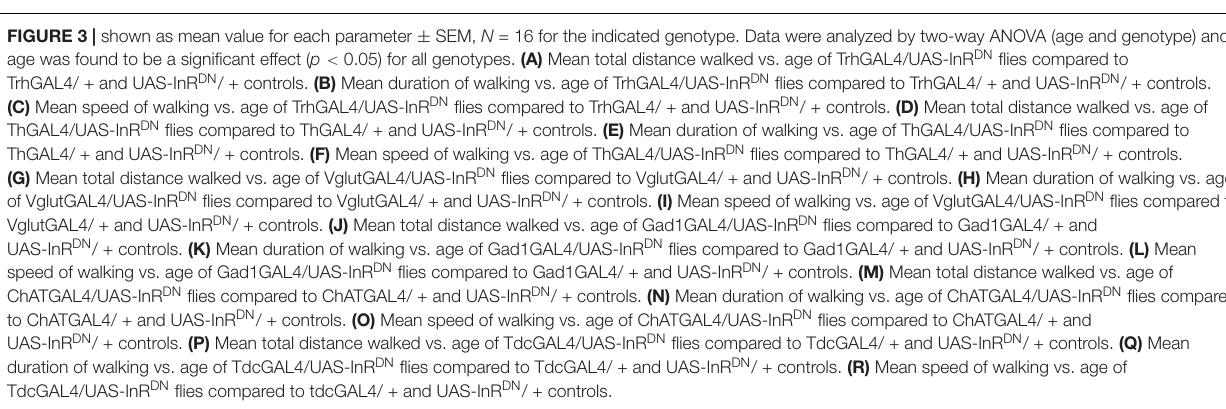
FIGURE 3 | shown as mean value for each parameter ± SEM, N = 16 for the indicated genotype. Data were analyzed by two-way ANOVA (age and genotype) and age was found to be a significant effect ( p < 0.05) for all genotypes. (A) Mean total distance walked vs. age of TrhGAL4/UAS-InR DN flies compared to TrhGAL4/ + and UAS-InR DN / + controls. (B) Mean duration of walking vs. age of TrhGAL4/UAS-InR DN flies compared to TrhGAL4/ + and UAS-InR DN / + controls. (C) Mean speed of walking vs. age of TrhGAL4/UAS-InR DN flies compared to TrhGAL4/ + and UAS-InR DN / + controls. (D) Mean total distance walked vs. age of ThGAL4/UAS-InR DN flies compared to ThGAL4/ + and UAS-InR DN / + controls. (E) Mean duration of walking vs. age of ThGAL4/UAS-InR DN flies compared to ThGAL4/ + and UAS-InR DN / + controls. (F) Mean speed of walking vs. age of ThGAL4/UAS-InR DN flies compared to ThGAL4/ + and UAS-InR DN / + controls. (G) Mean total distance walked vs. age of VglutGAL4/UAS-InR DN flies compared to VglutGAL4/ + and UAS-InR DN / + controls. (H) Mean duration of walking vs. age of VglutGAL4/UAS-InR DN flies compared to VglutGAL4/ + and UAS-InR DN / + controls. (I) Mean speed of walking vs. age of VglutGAL4/UAS-InR DN flies compared to VglutGAL4/ + and UAS-InR DN / + controls. (J) Mean total distance walked vs. age of Gad1GAL4/UAS-InR DN flies compared to Gad1GAL4/ + and UAS-InR DN / + controls. (K) Mean duration of walking vs. age of Gad1GAL4/UAS-InR DN flies compared to Gad1GAL4/ + and UAS-InR DN / + controls. (L) Mean speed of walking vs. age of Gad1GAL4/UAS-InR DN flies compared to Gad1GAL4/ + and UAS-InR DN / + controls. (M) Mean total distance walked vs. age of ChATGAL4/UAS-InR DN flies compared to ChATGAL4/ + and UAS-InR DN / + controls. (N) Mean duration of walking vs. age of ChATGAL4/UAS-InR DN flies compared to ChATGAL4/ + and UAS-InR DN / + controls. (O) Mean speed of walking vs. age of ChATGAL4/UAS-InR DN flies compared to ChATGAL4/ + and UAS-InR DN / + controls. (P) Mean total distance walked vs. age of TdcGAL4/UAS-InR DN flies compared to TdcGAL4/ + and UAS-InR DN / + controls. (Q) Mean duration of walking vs. age of TdcGAL4/UAS-InR DN flies compared to TdcGAL4/ + and UAS-InR DN / + controls. (R) Mean speed of walking vs. age of TdcGAL4/UAS-InR DN flies compared to tdcGAL4/ + and UAS-InR DN / +